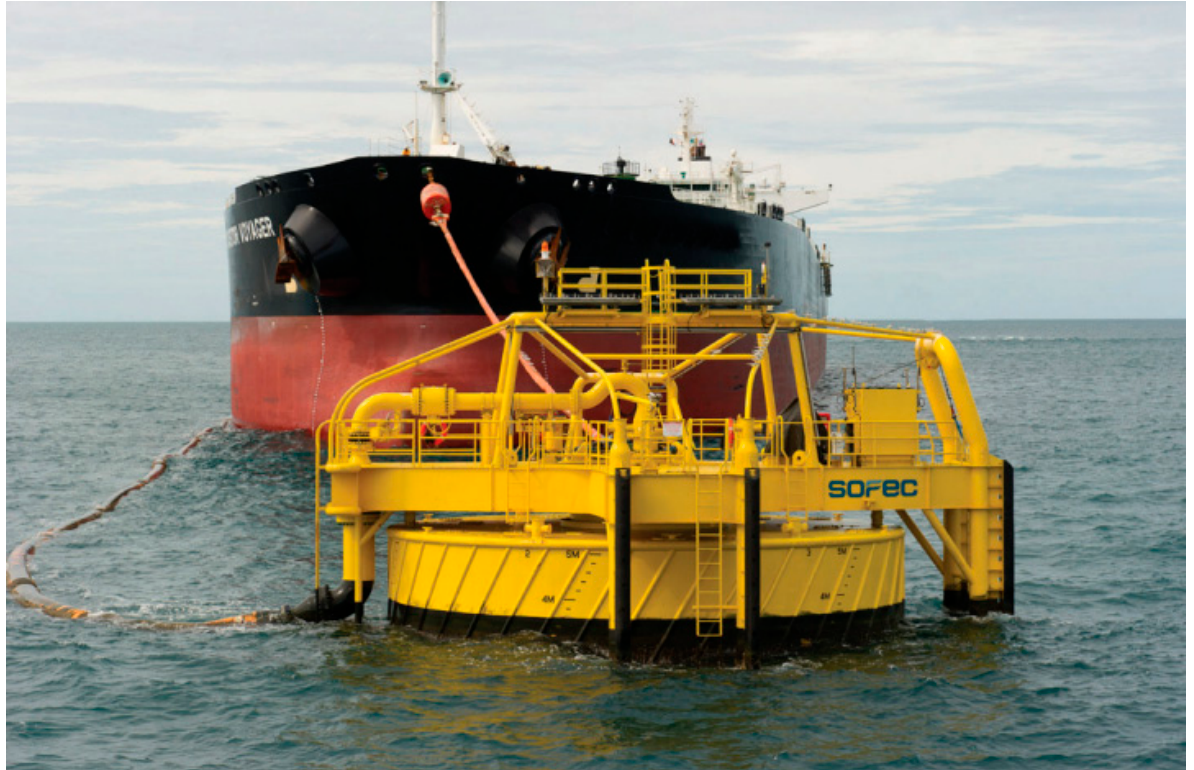
Figure 2. CALM Buoy attached to an FSO in the Baltic Sea offshore Lithuania (Adapted with permission of SOFEC Inc.; Courtesy: SOFEC; Source: [49]).